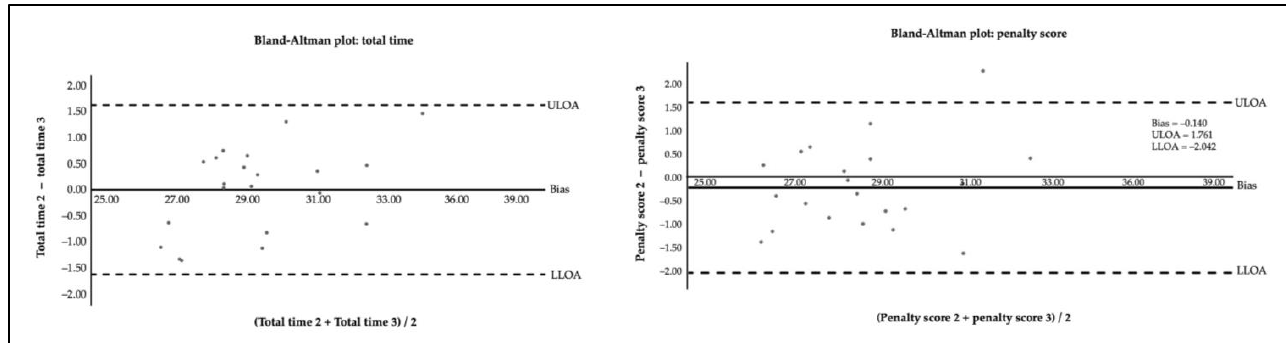
5 of 8 Table 3. Reliability, technical error of measurement, coefficient of variation, and intraclass correla- tion between Trials 2 and 3. Variable